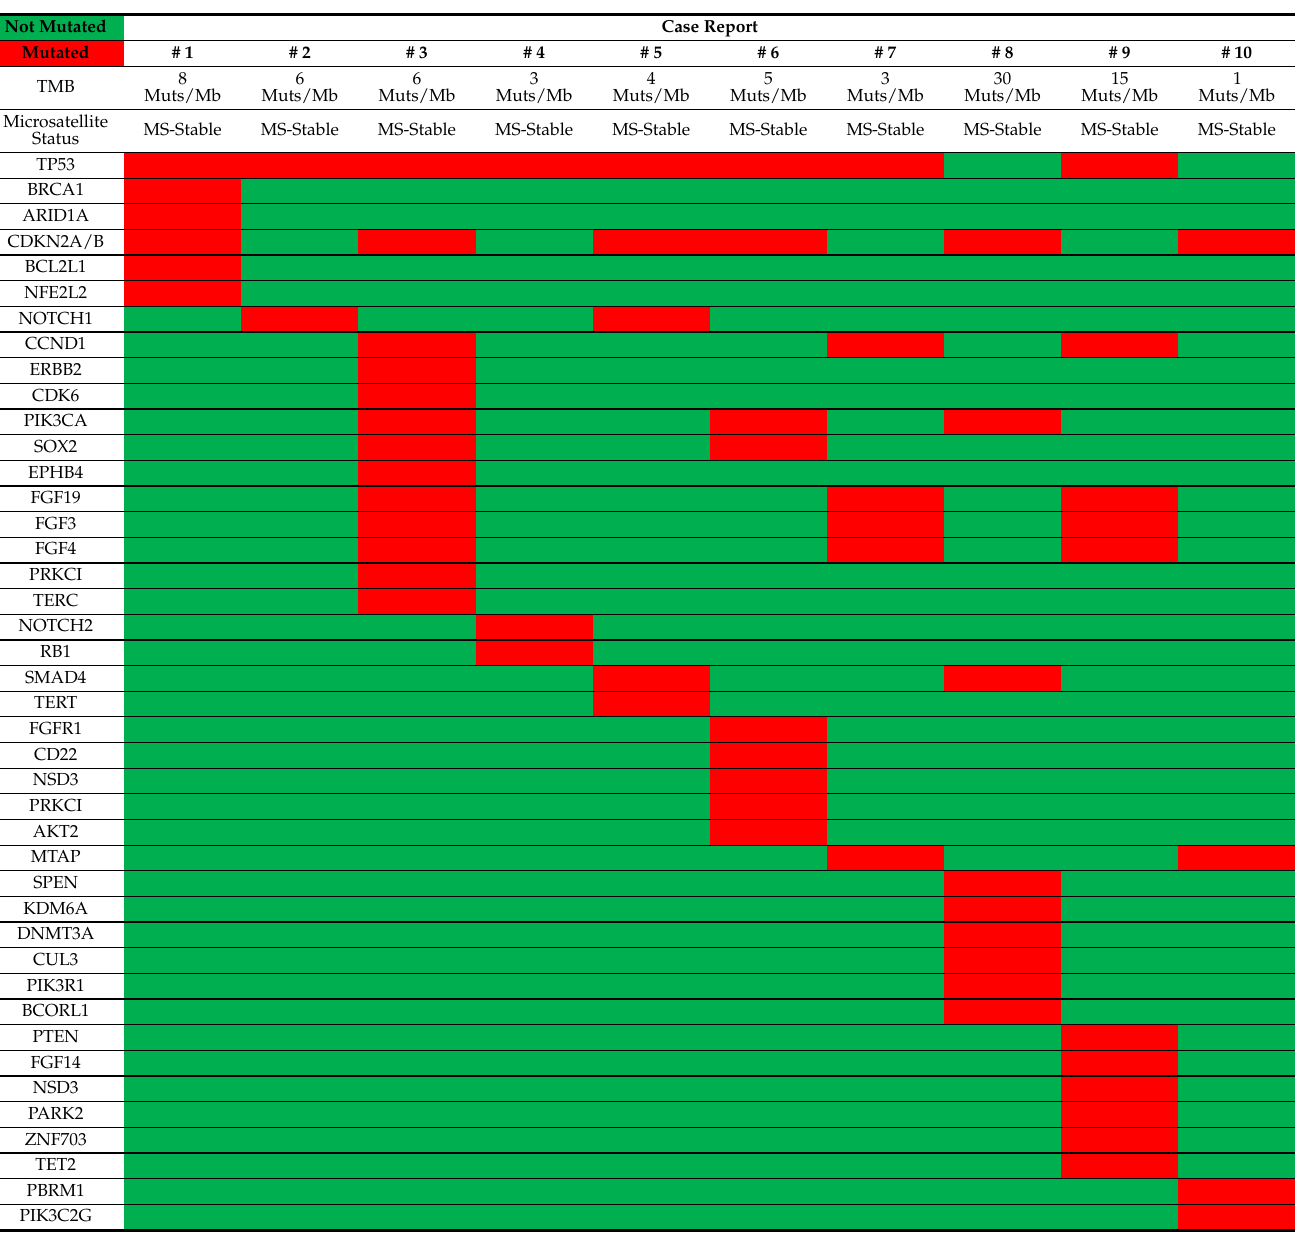
Table 3. Genomic profile of patients with R/M